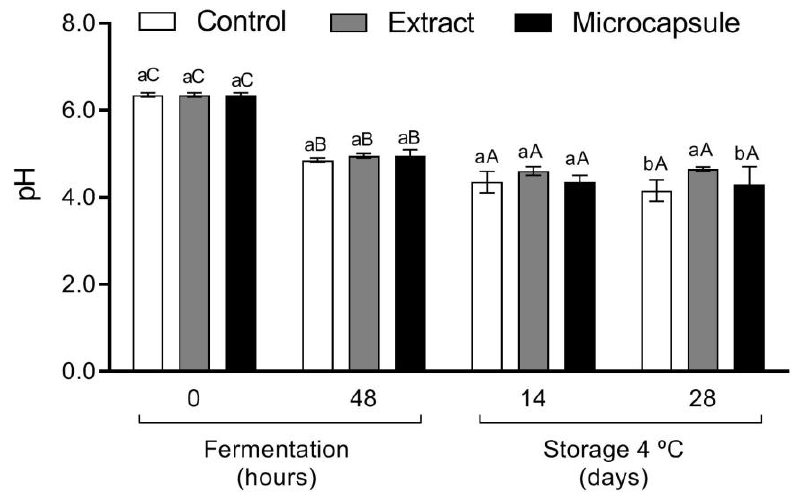
Figure 3. Reduction in pH during the fermentation process. Different lowercase letters denote differ- ences ( p < 0.05) among assays simultaneously. Different capital letters denote differences ( p < 0.05) in the same assay at different times according to the Scott–Knott test. [Non-dairy matrix (N-DM): 1 Control—consists only of the fermented beverage (N-DM); 2 Extract—beverage (N-DM) with propo- lis extract (DPE); 3 Microcapsule—beverage (N-DM) with microencapsulated propolis (D.M.P.)].